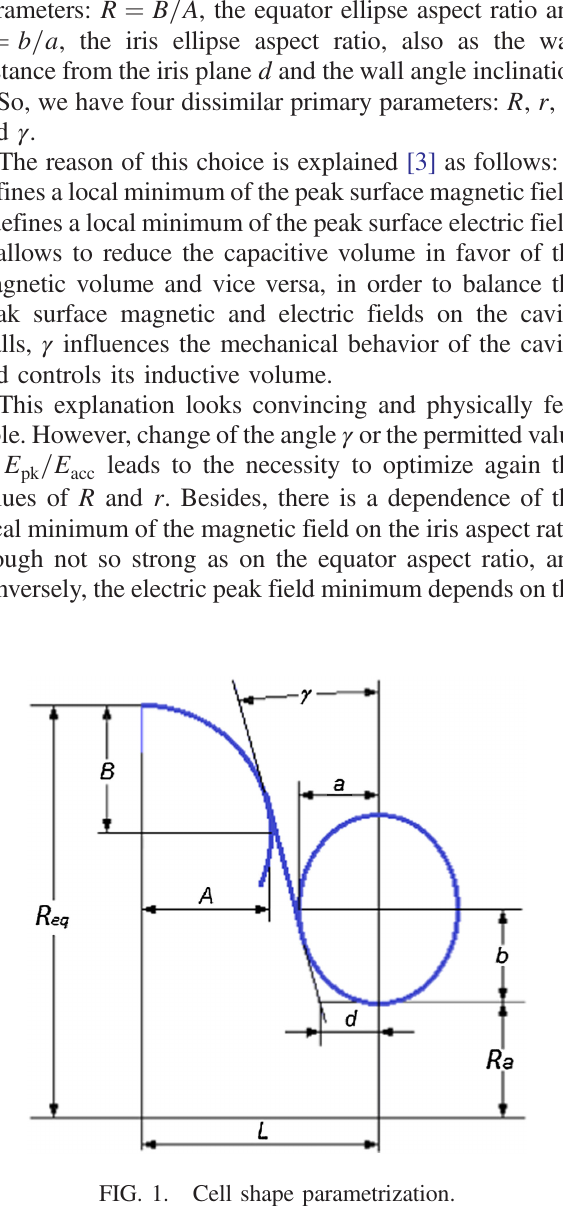
FIG. 1. Cell shape